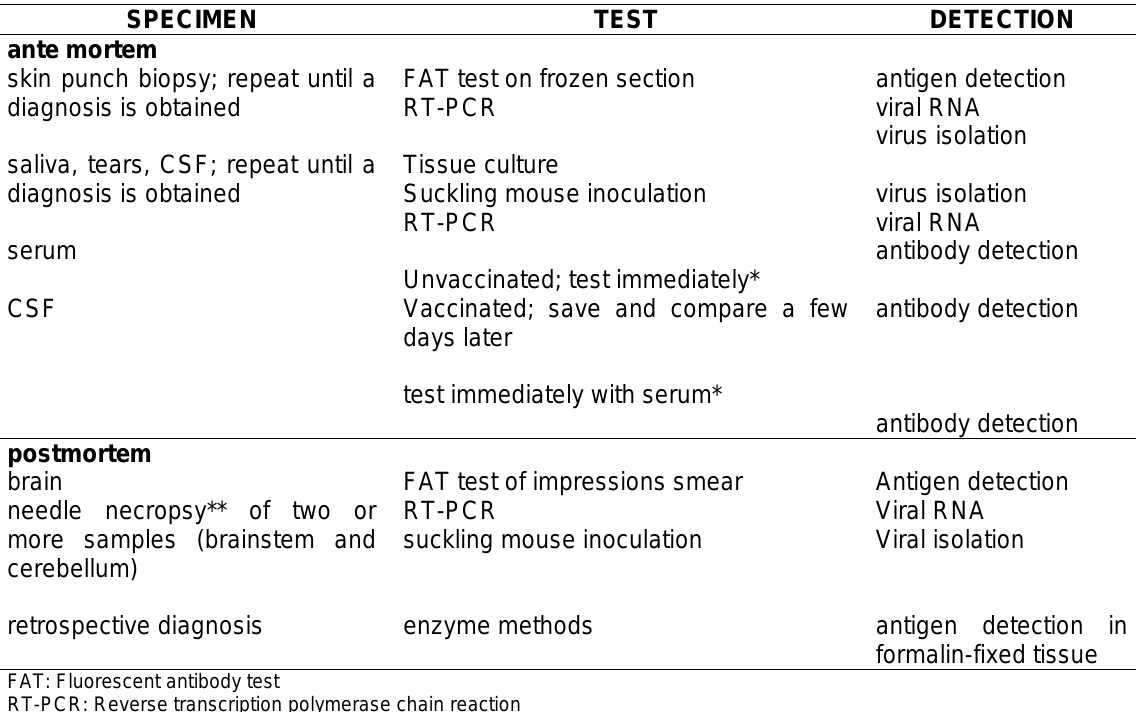
Table 2: Diagnosis of human